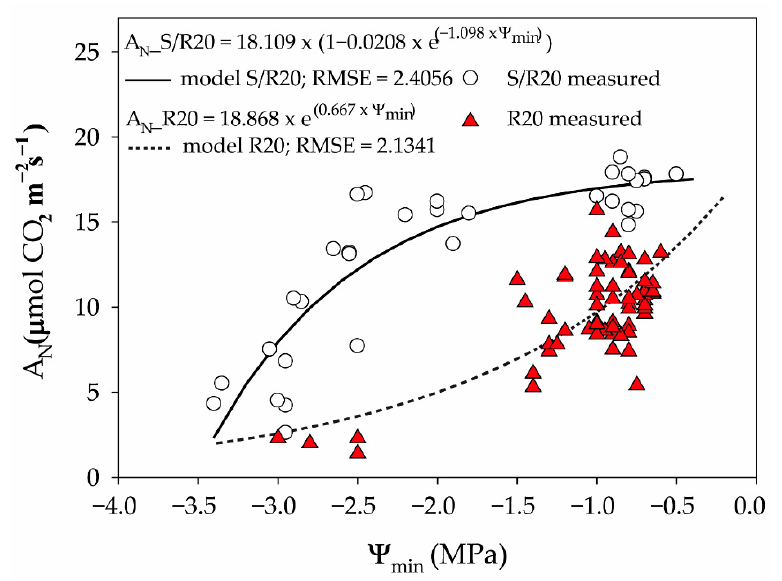
Figure 3. Effect of midday minimum water potential ( Ψ min ) on net photosynthesis (A N ) during substrate desiccation of the S/R20 and R20 Prunus cultivars. Dots and triangles indicate data measured for the S/R20 and R20 cultivars and lines indicate data modeled for S/R20 in a continuous line and R20 in a dashed line. Adjusted models for both cultivars are shown in the panel.